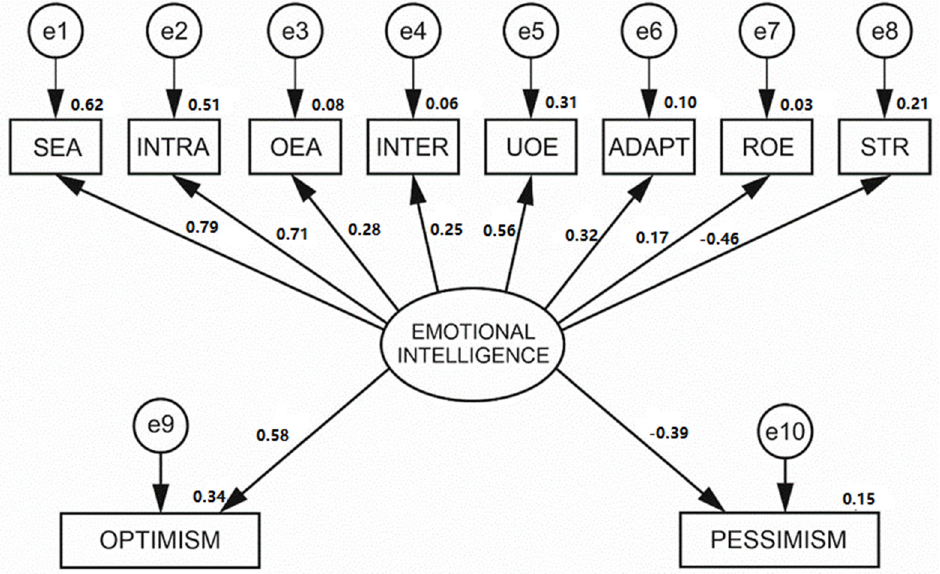
Figure 3. Multi-group structural equation model for women.